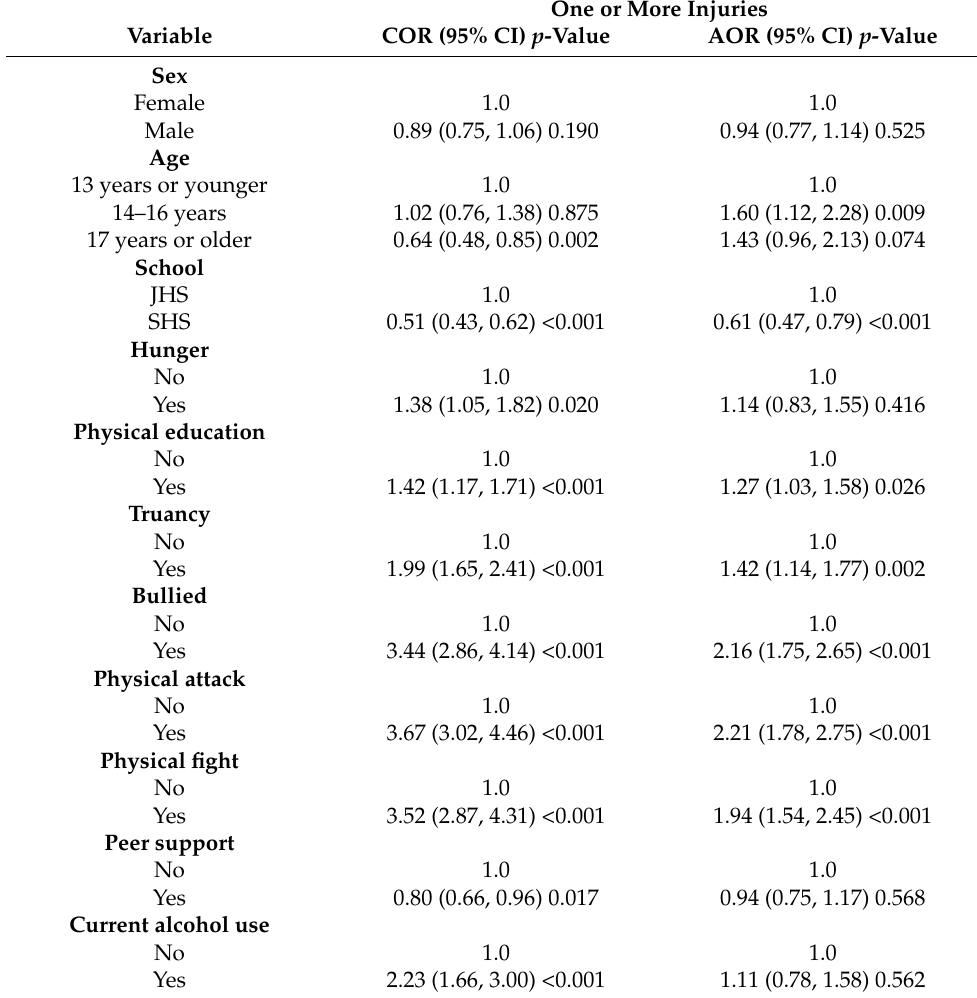
Table 4. Binary logistic regression analysis of predictors of unintentional